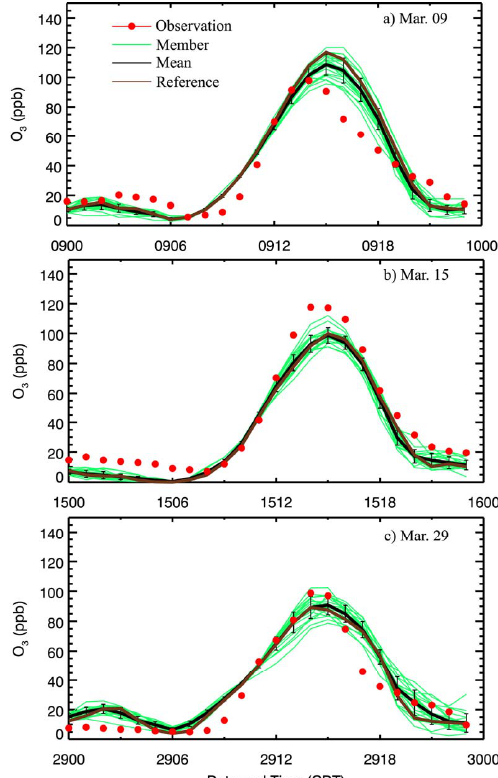
Fig. 13. Same as in Fig. 5a, but for 9, 15, and 29 March